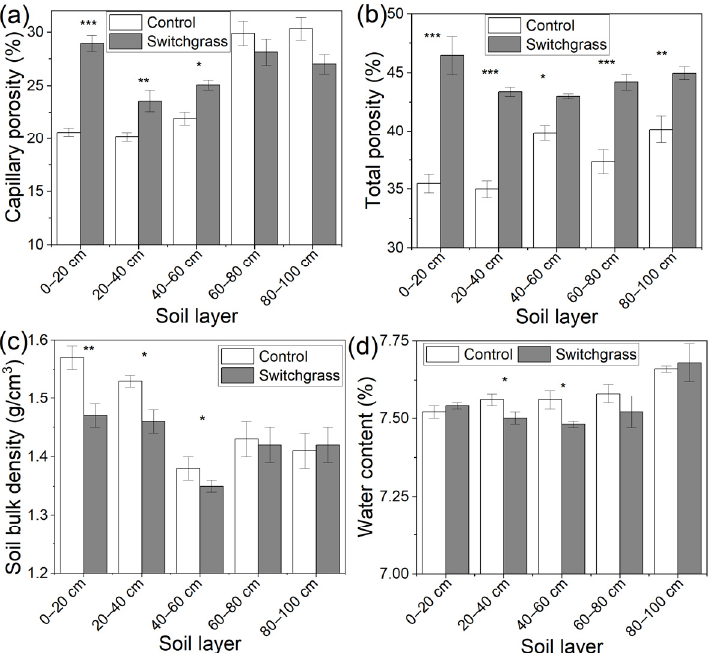
Figure 1. Soil ( a ) capillary porosity, ( b ) total porosity, ( c ) bulk density, and ( d ) water contents in the bare land (control) and switchgrass-cultivated land. Error bars (standard deviation) were correctly added at the top of the mean columns. A Wilcoxon rank-sum test was used to analyze the significant differences in each soil index between control and switchgrass land at p < 0.05 (*), 0.01 (**), and 0.001 (***) levels.